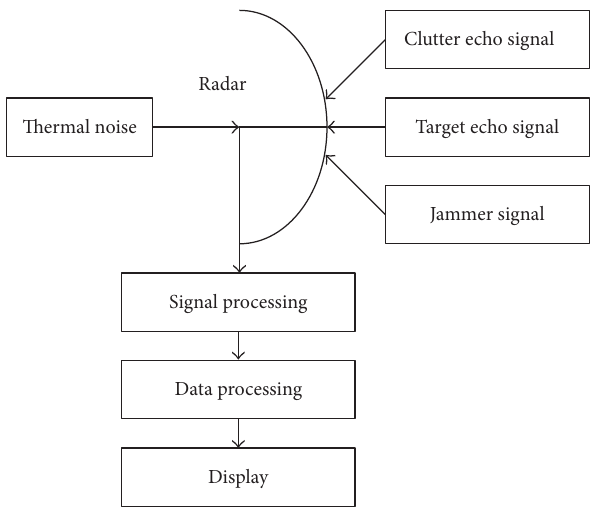
Figure 7: A radar model detection